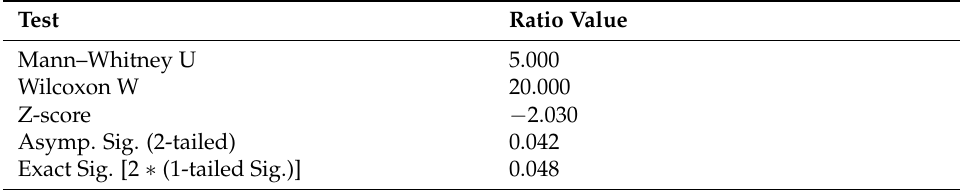
Table 3. Mann-Whitney U test for bruxism